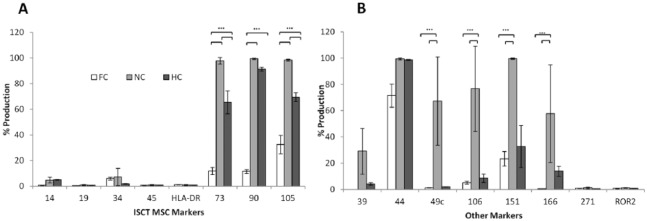
Flow cytometry data showing the presence of cell markers indicative of (A) mesenchymal stem cell (MSC; using the ISCT criteria). (B) Other markers indicative of chondrogenic dedifferentiation, potency, and immunomodulation on freshly isolated chondrocytes (FC) (n = 5), normoxic chondrocytes (NC) at P3-4 (n = 5), and hypoxic chondrocytes (HC) at P3-4 (n = 4). Error bars indicate the mean ± SD.